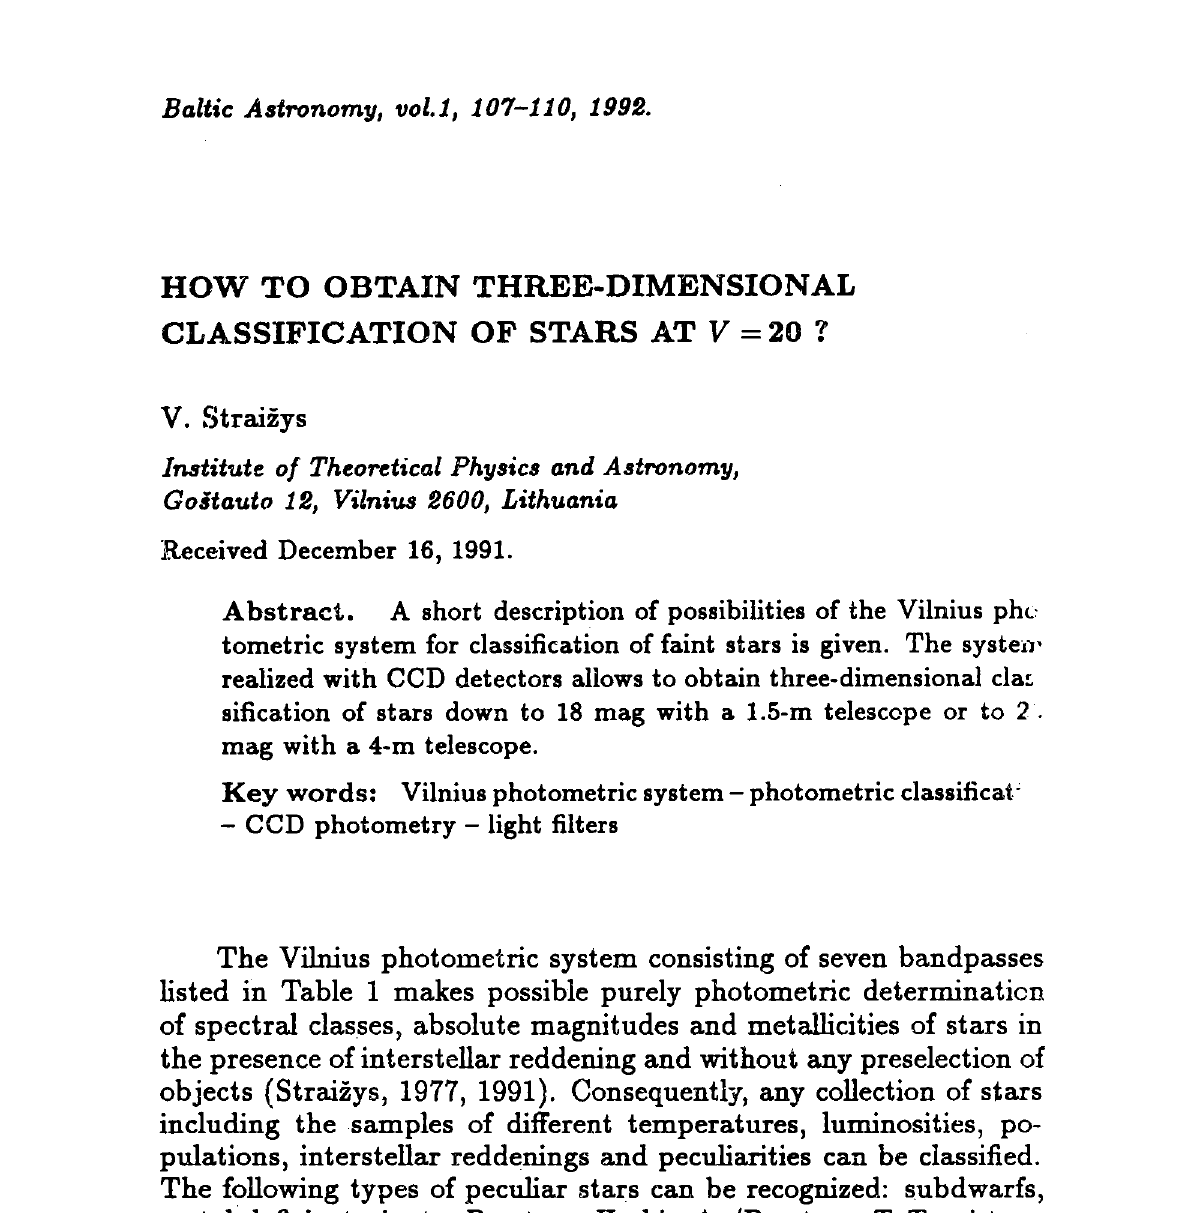
Table 1. Mean wavelenghts and half-widths of bandpasses of the Vilnius